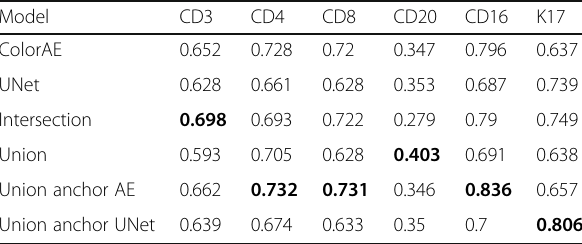
Table 2 F1 Scores evaluating predictions from UNet, ColorAE, and ensemble methods against dilated seed labels Model CD3 CD4